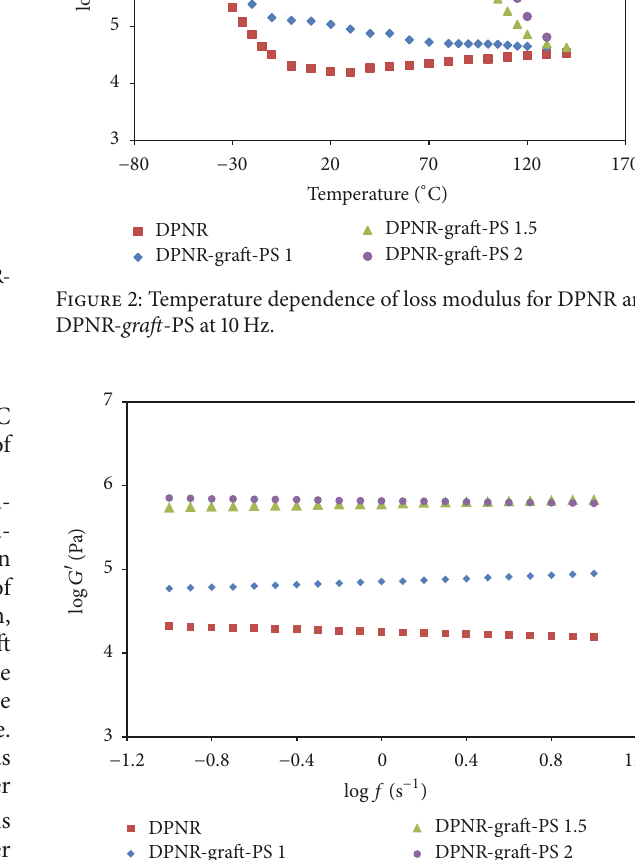
Figure 3. The storage modulus is related to the elastic